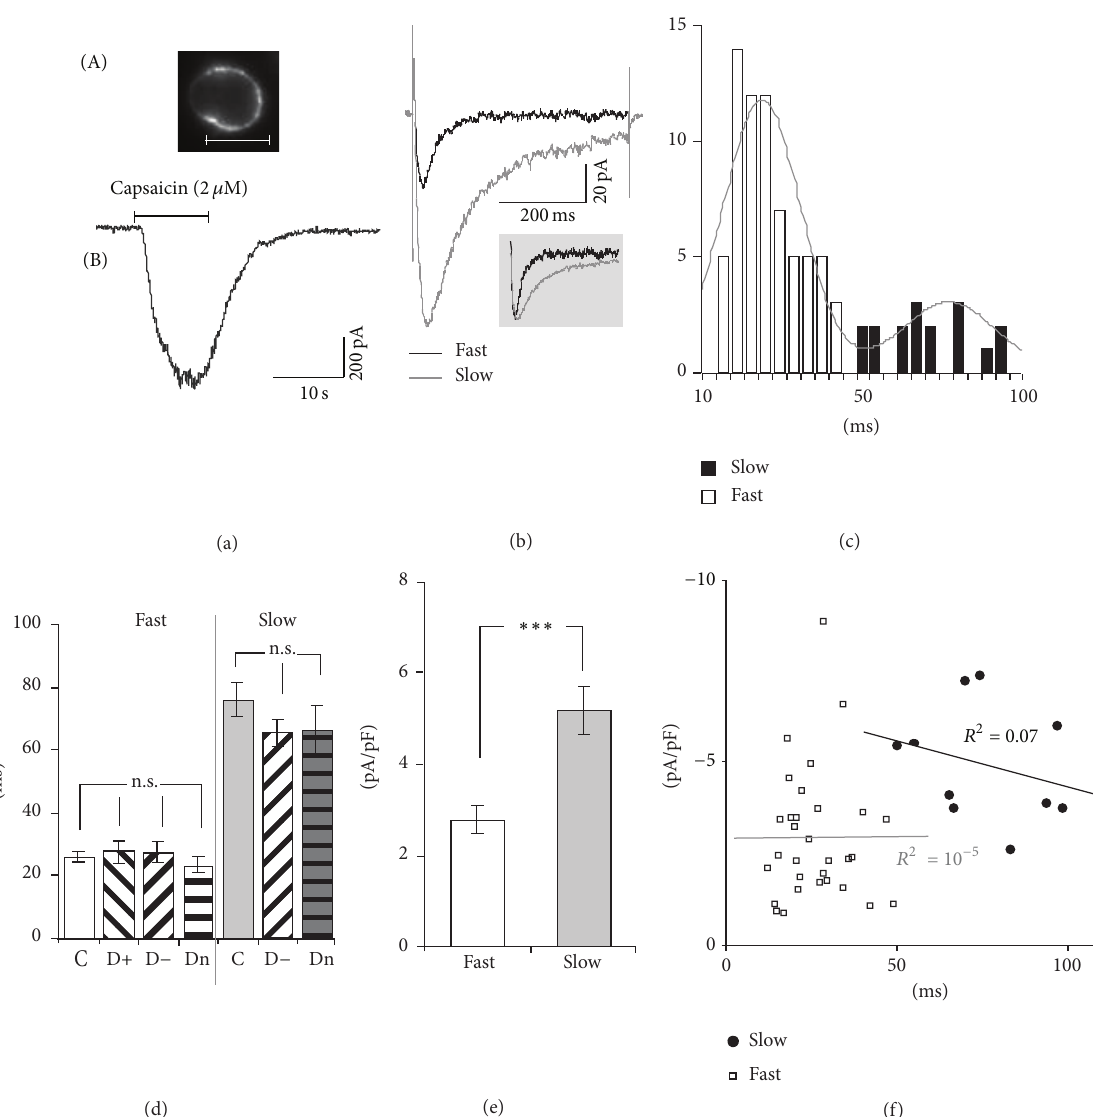
Figure 1: NTCN neurons express both fast and slow T-currents. (a) Identification of NTCN neurons. (A) A typical fluorescent image of an IB4-positive small-size DRG neuron. Note the intensive fluorescent ring associated with the neuronal plasma membrane. Scale bar, 20 𝜇 m. (B) A typical trace of transmembrane current induced by application of capsaicin (2 𝜇 M) in IB4-positive small-sized DRG neuron. IB4- positive capsaicin-sensitive small size DRG neurons were further considered as nonpeptidergic thermal C-type nociceptive (NTCN) neurons. (b) Representative current traces illustrate expression of T-currents with fast and slow kinetics of inactivation in different NTCN neurons. Currents were elicited using a 0.5 s voltage step to − 45 mV after preconditioning at − 95 mV for 3 s. A grey inset shows the same currents normalized by amplitude to underline a difference in kinetics of current inactivation. (c) A histogram demonstrates a pooled distribution of inactivation time constants of T-currents recorded from 85 neurons of control and PDN groups. The time constants were calculated from a single-exponential fit of current decay. A smooth curve is a fit of the distribution by a sum of two Gaussians. According to this fit T-currents < 50 ms; white bars) and slow ( 𝜏 > 50 ms; black bars) subtypes. (d) Kinetics of inactivation of fast and slow T- were divided into fast ( 𝜏 in in currents in control and PDN groups. Each column is the mean and SEM from the number of neurons specified in Figure 2(a). No significant difference compared to control was revealed under PDN conditions in kinetics of inactivation for both fast and slow T-currents. (e) Peak current density (PCD) of fast and slow T-currents under the control conditions. The columns are the mean and SEM calculated from 31 fast and 12 slow T-currents. ∗∗∗ 𝑃 < 0.001 . (f) PCD plotted versus inactivation time constant for fast and slow T-currents recorded under the control conditions. No significant correlations were found for both current types indicating that the difference in inactivation between fast and slow T-currents was not due to voltage clamp problems. Lines were liner fits of the dependencies; 𝑅 2 as a measure of correlation is